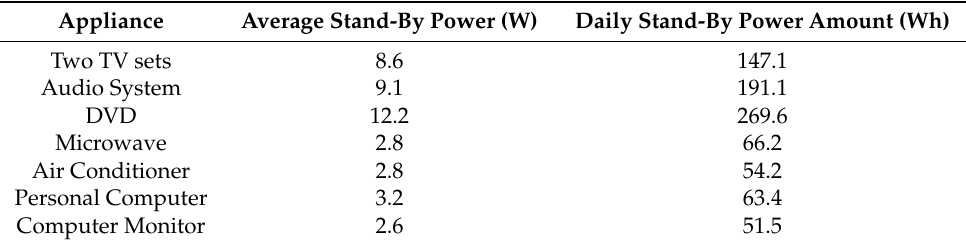
Table 6. Consumption amount of stand-by power.